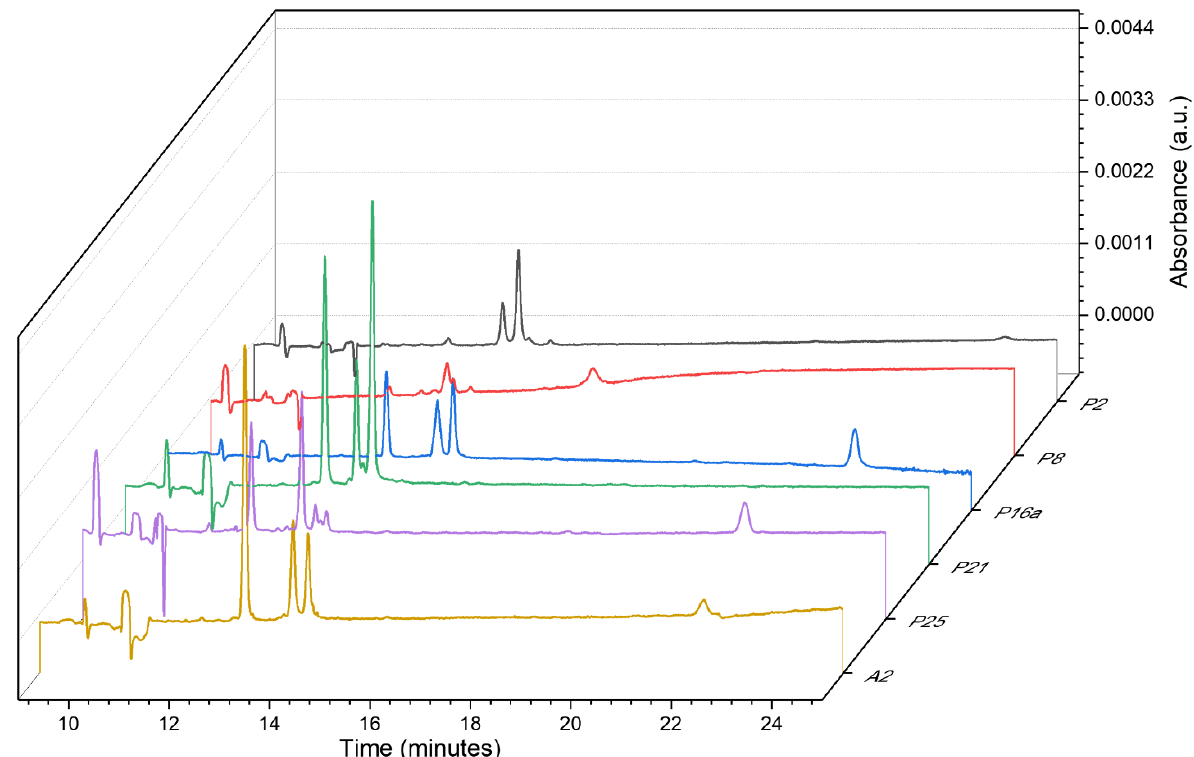
Figure 7. Comparison of electropherograms with dye signals, recorded at 220 nm for the extracts from fibers included in group 2 from green fabrics and sample A2, secured from one of the textiles. Table 5. Results of differentiation of samples from a group of green fabrics (2) and sample A2; yellow, red, and blue colors corresponding to signals with the maximum absorption bands at 380–490, 490–580, and >580 nm,